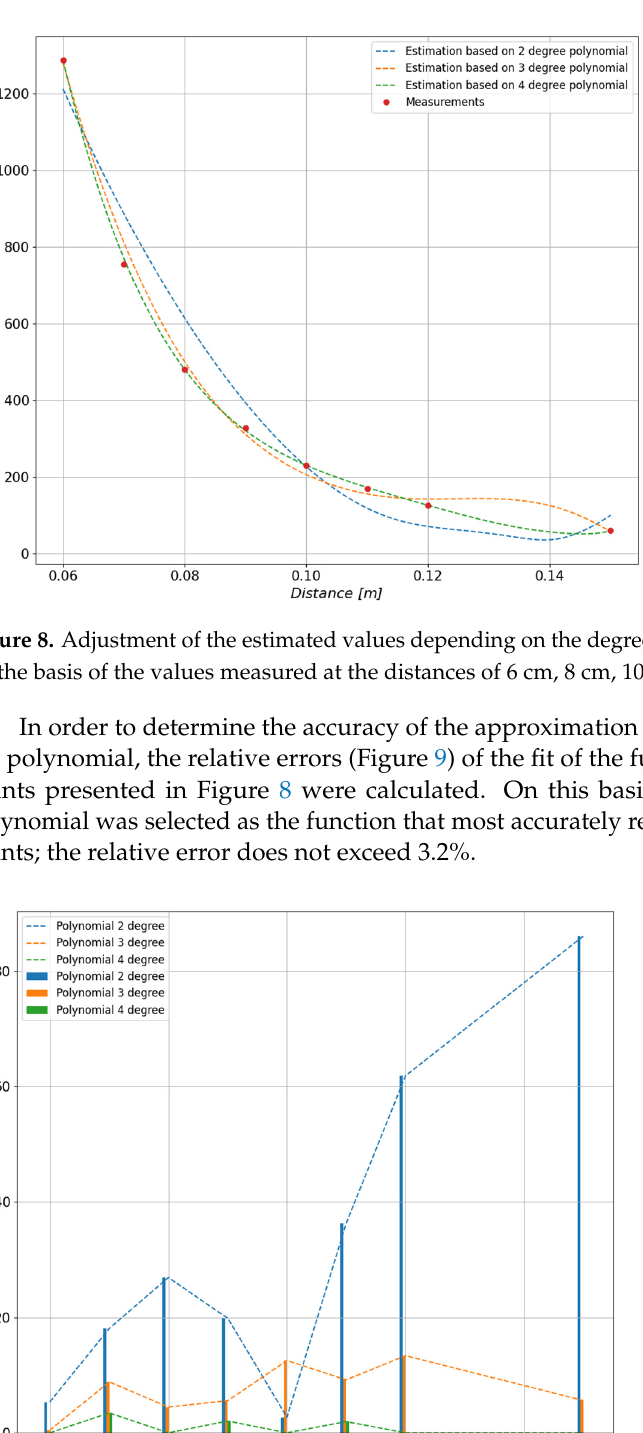
Figure 9. Values of the relative errors depending on the degree of the polynomial determined on the basis of values measured at distances of 6 cm, 8 cm, 10 cm, 12 cm, and 15 cm.